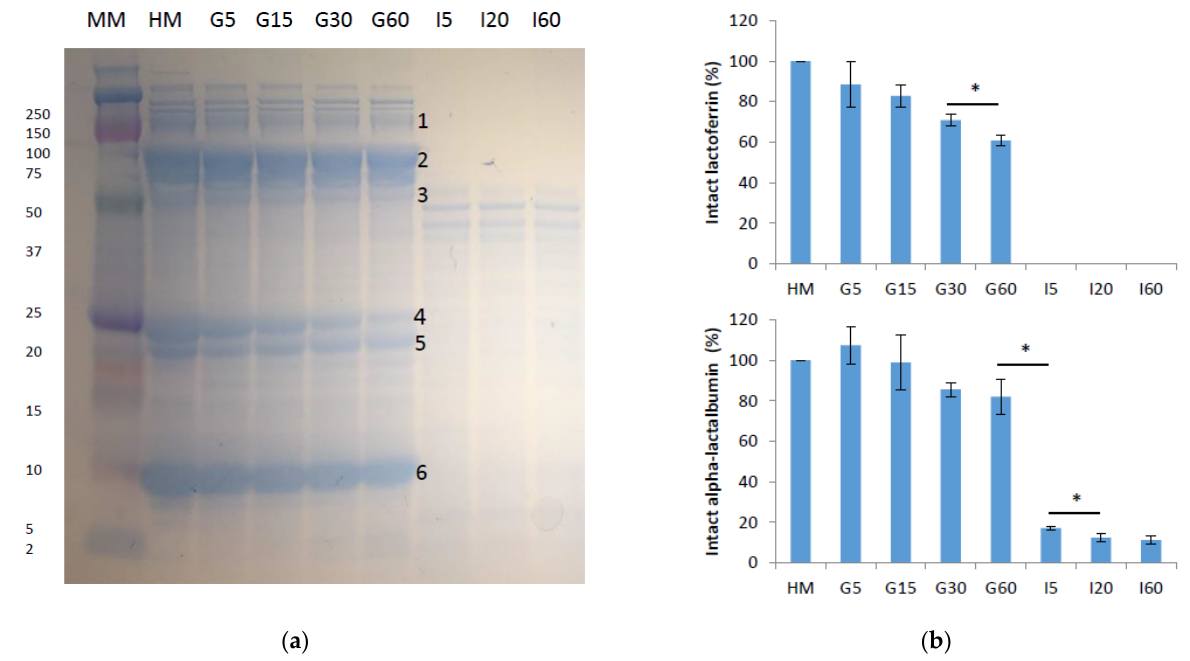
Figure 4. ( a ) SDS-PAGE profile of a mature milk sample submitted to in vitro gastrointestinal digestion. Band identification by tandem MS: 1. Bile salt-activated lipase. 2. Lactoferrin. 3. Immunoglobulin heavy constant alpha 4. β -casein. 5. β - and α s1-casein. 6. α -LA. ( b ) Quantification of lactoferrin and α -LA by UPLC ( n = 4). * p < 0.05 ( t -test) MM: molecular marker; HM: human milk; gastric digestion time 5 (G5), 15 (G15), 30 (G30) and 60 (G60) min; intestinal digestion time 5 (I5), 20 (I20) and 60 (I60) min.